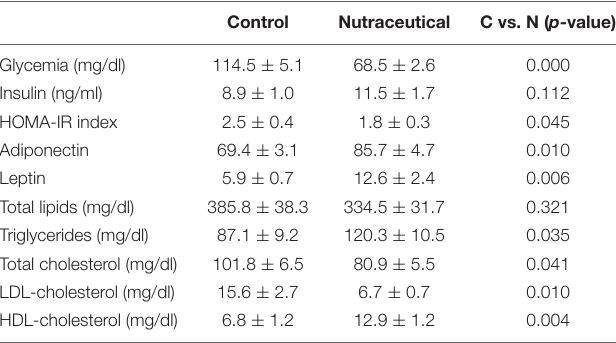
TABLE 2 | Glycemia, lipid profile, insulin, and HOMA-IR in the serum of rats treated with vehicle, LPS or LPS + Nutraceutical.